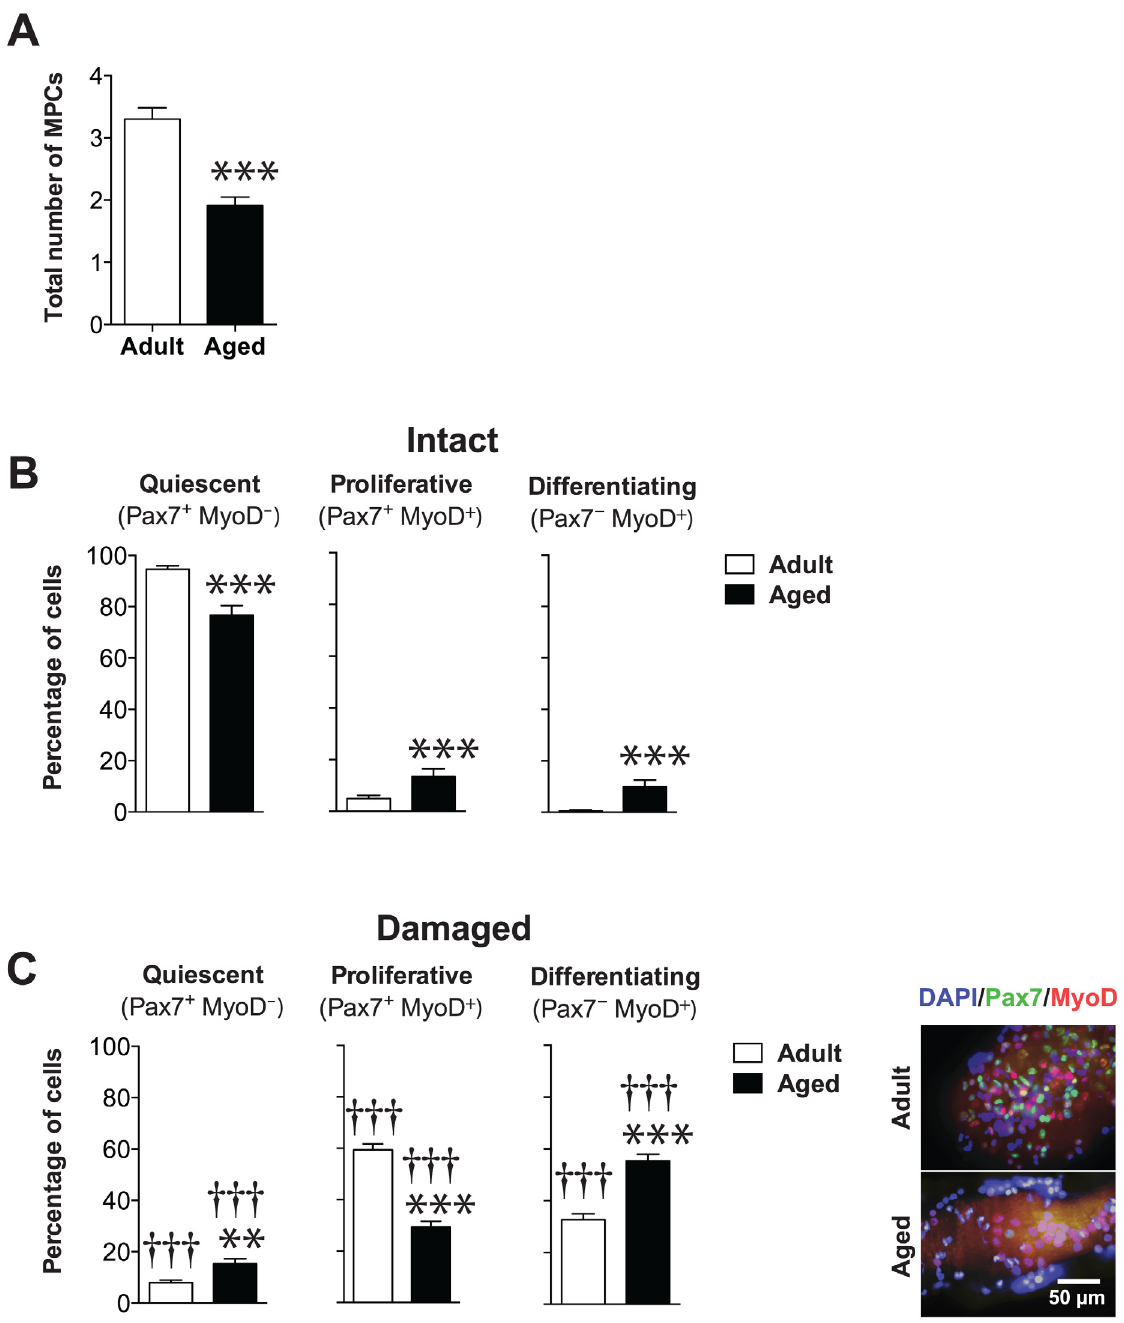
Fig 1. MPCs in aged myofibers display decreased myogenic activity. (A ) Histograms showing the total number of MPCs per myofiber on 5 – 109 freshly isolated and cultured (6 days) myofibers from adult and aged mice ( n = 5 mice per group). (B, C) Histograms showing the percentage of quiescent SCs (Pax7 + MyoD − ) and proliferating (Pax7 + MyoD + ) and differentiating MPCs (Pax7 − MyoD + ) per myofiber on intact (B) and damaged (C) myofibers. The Pax7 and MyoD proteins were immunostained as shown in the photomicrograph on the right. The count includes all parts and depths of the myofibers. The representative image on the right shows that Pax7 and MyoD proteins are expressed at lower levels in aged myofibers. ** p < 0.01 and *** p < 0.0001 versus adult. ††† p < 0.001 versus intact counterparts. All data are expressed as means ± SEM.